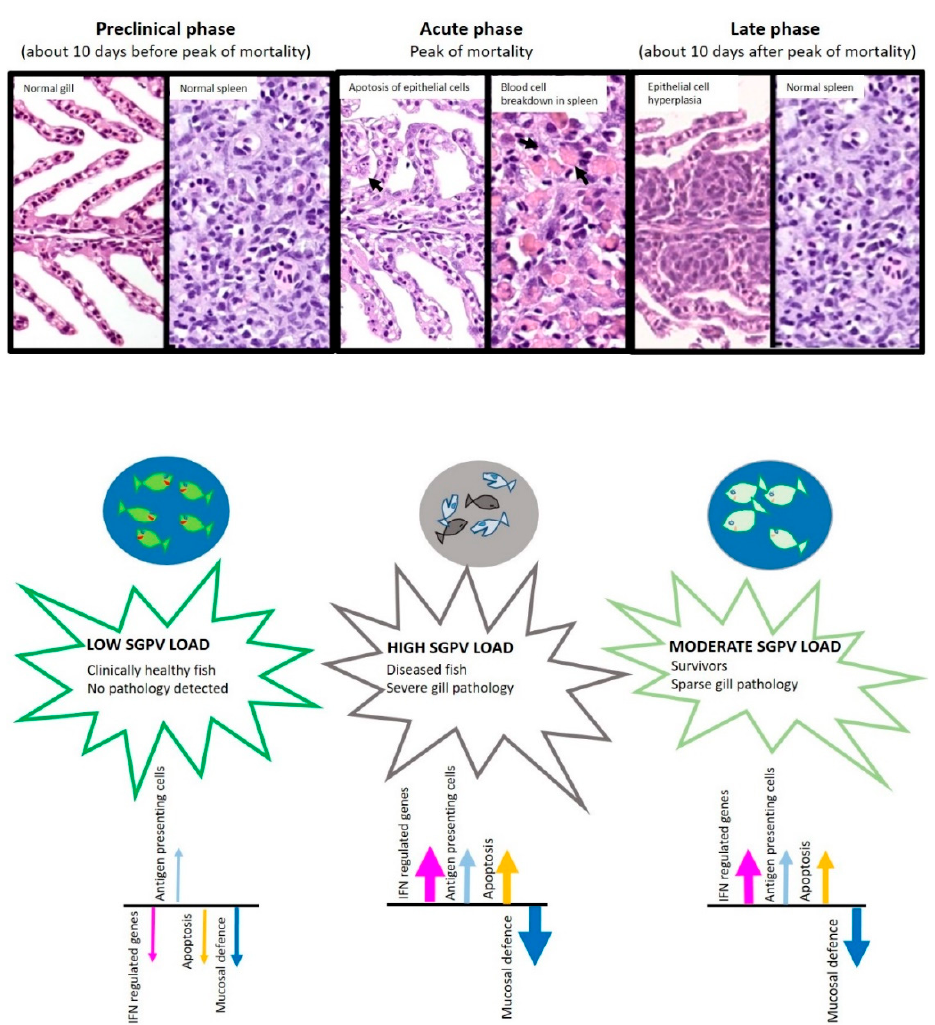
Figure 1. Salmon gill poxvirus disease course from the preclinical phase to the late phase. Histology images (top) show gills and spleens in the different phases of the disease. The lower panel indicates information gained from transcriptomic data from a field outbreak [7] with arrows illustrating gene regulation (up/down/arrow thickness indicates degree) associated with different biological processes in the gills at the different stages of disease. During the pre-clinical phase, the gills appear normal and with no histologically observable erythrophagocytosis in the spleen, the SGPV load is low, and gene regulation is not significantly affected. During the acute phase, extensive apoptosis of gill epithelial cells is seen and, in some cases, erythrophagocytosis in the spleen. High SGPV levels, upregulation of IFN-regulated genes, and downregulation of mucosal defence genes in the gills are also identified. In the later phase, sparse hyperplasia of gill epithelial cells can occasionally be seen, spleens appear normal, and SGPV levels are moderate. IFN regulated genes remain induced in the gills, and mucosal defence genes suppressed.